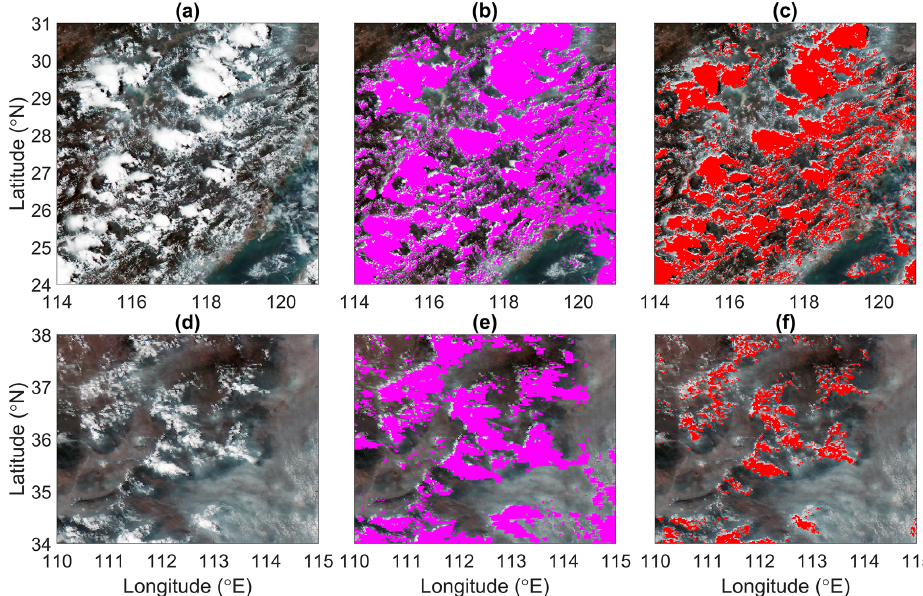
Figure 3. Comparisons between MODIS cloud mask and the cloud identified by our convective cloud (CC) mask, at 13:40LT on 30 July 2016 and 14:20LT on 22 June 2016. (a,d) The true-color image, (b,e) MODIS cloud mask data from the MYD35 product (magenta points), and (c,f) convective clouds (CC) identified using the TCT-CID